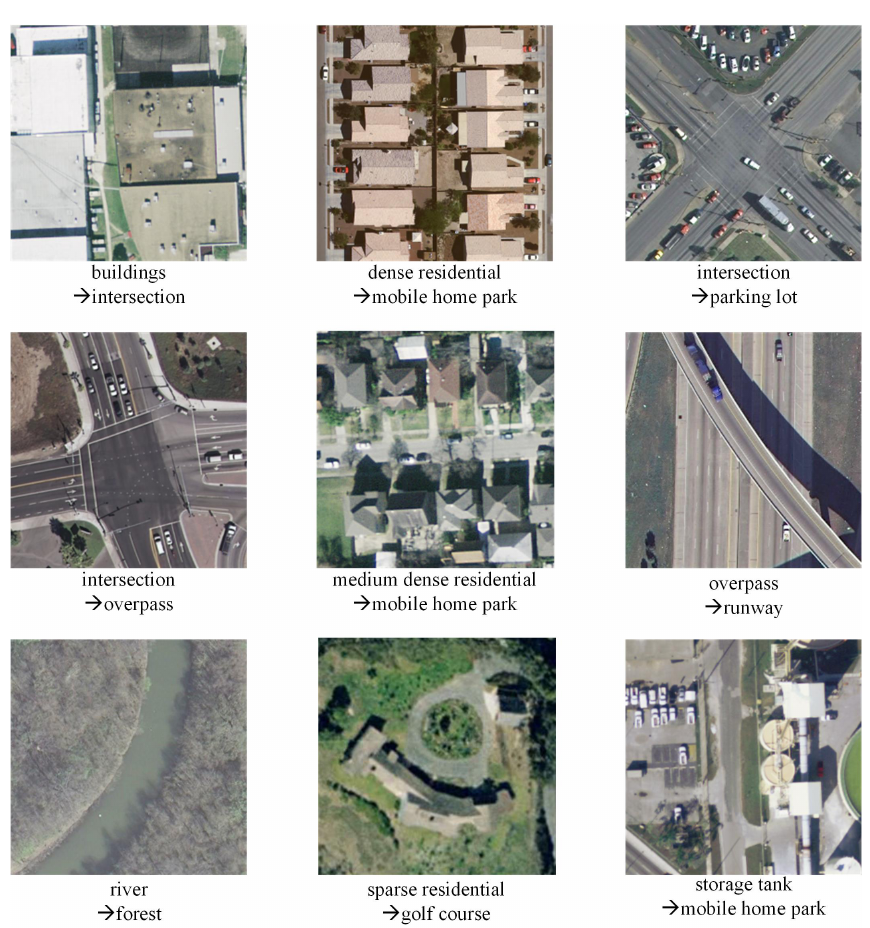
Figure 11. The representative misclassification